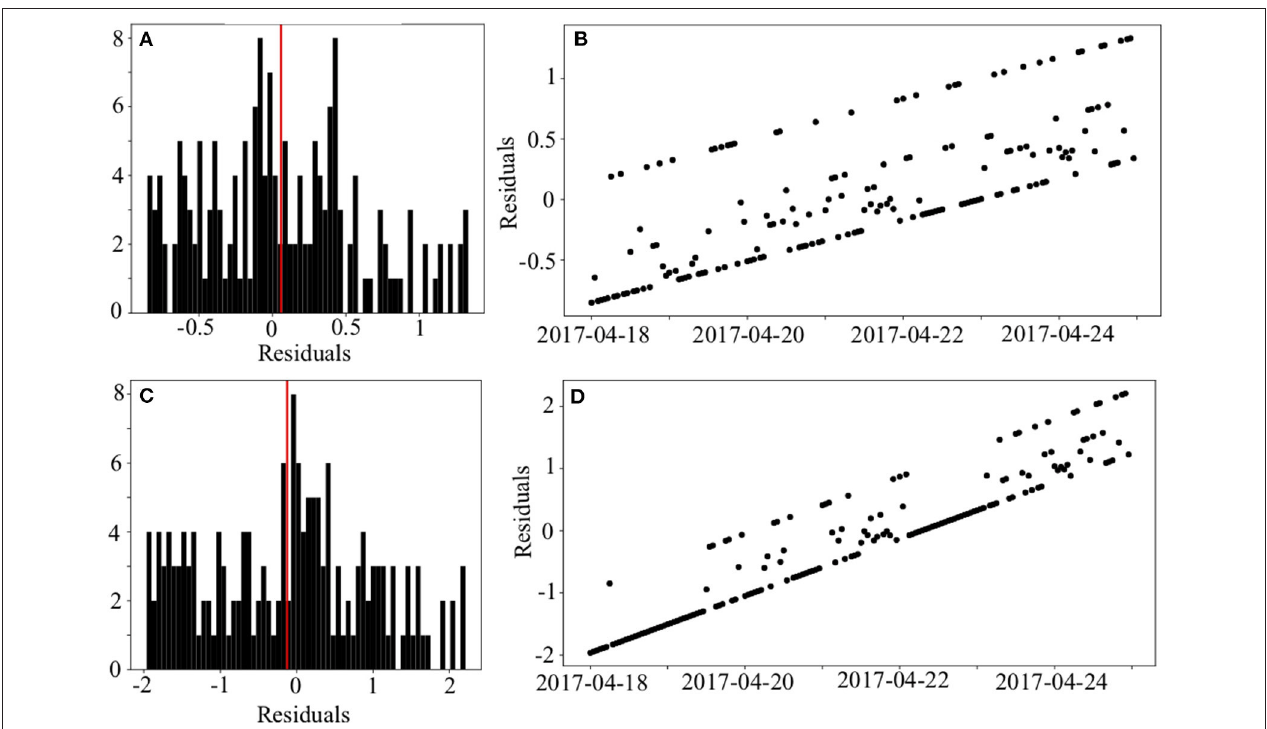
FIGURE 7 | Residual analysis for least squares linear regressions presented in Figure 6 . The y-axis of (A) and (C) depict the count. (A,B) Residual analysis for all families of seismicity identified. (C,D) Dominant LF family (30-03-2017 08:46). The vertical red line indicates the mean of the calculated residual values (A,C)